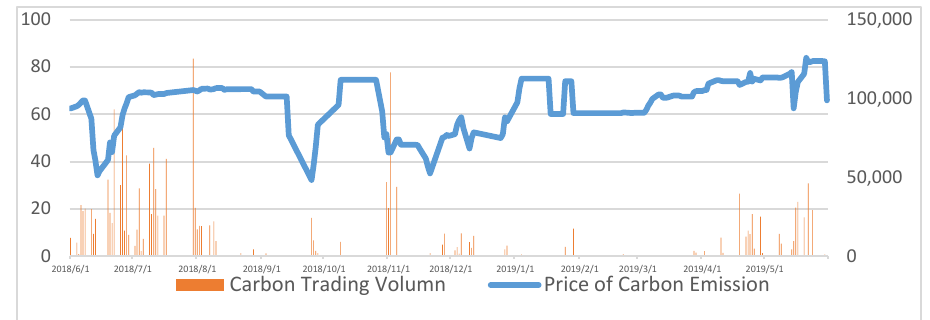
Figure 2. The price trend of carbon emission trading in Beijing (from June 2018 to May 2019). Notes: 1 USD is 6.6174 CNY.